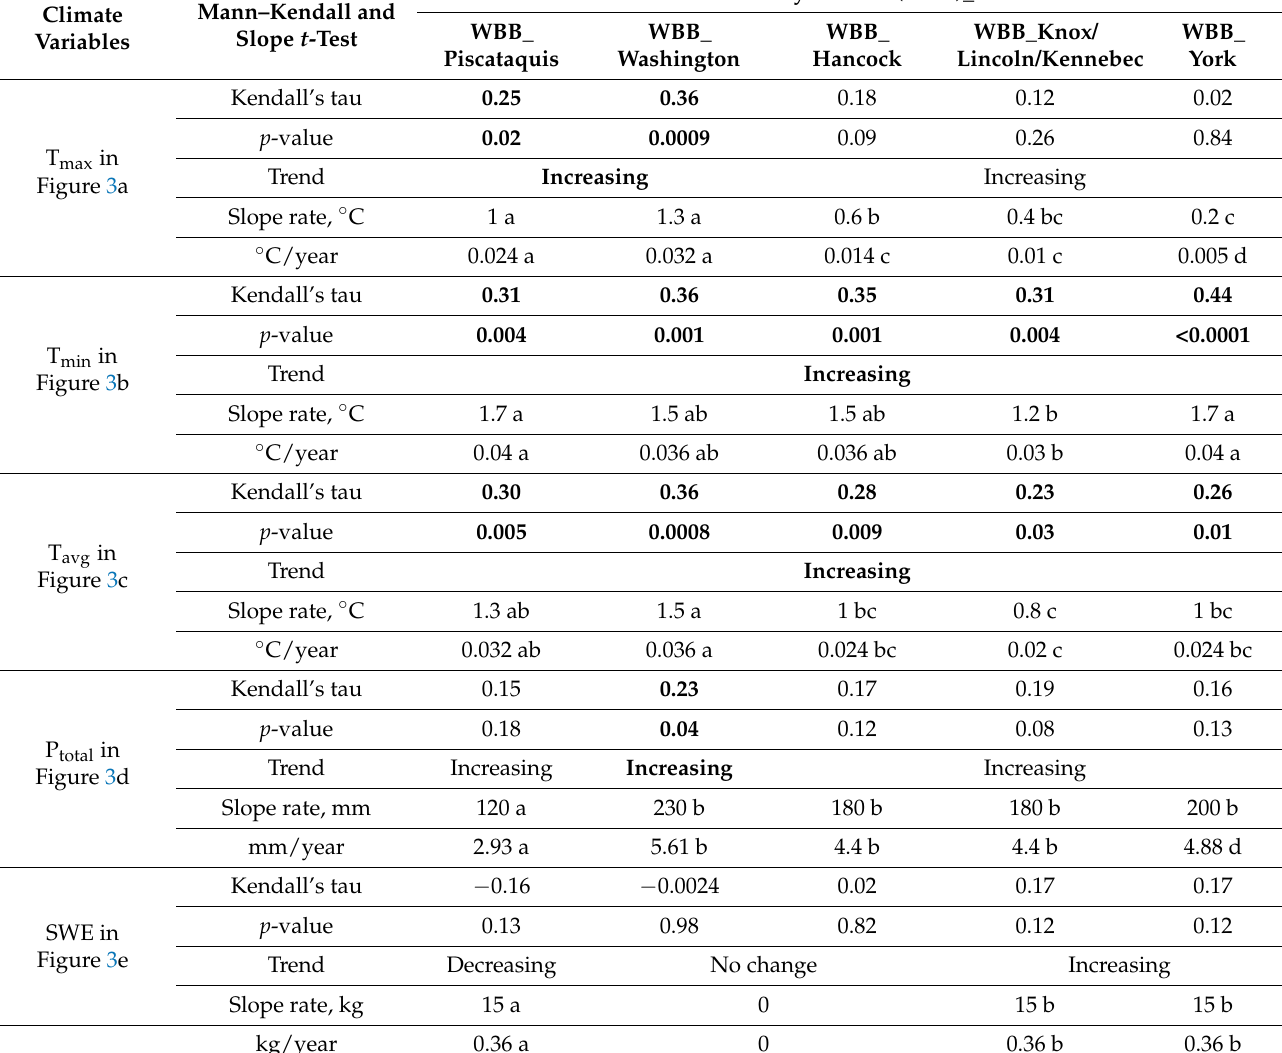
Table 1. Historical trend analysis of annual climate variables using Mann–Kendall test, and compar- ison of linear regression fitted slopes using slope t -test among the studied wild blueberry barrens (WBBs) in different counties from north-central (Piscataquis) and north-east (Washington, Hancock) to south-west (Knox, Lincoln, Kennebec, York) of Maine (shown in Figure 1) from 1980 to 2020. Red-colored parts indicate significant strength in historical climate trends. Different letters associated with the “Slope rate” indicate significant differences among the counties at a significance level of p < 0.05. Different letters “a–d” after the numbers indicate significant differences among the studied barrens in different